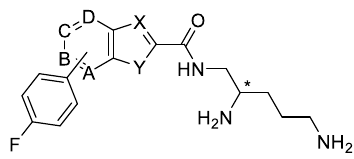
Figure 3. General structure of improved aryl hydrophobic head groups as potential EPIs.